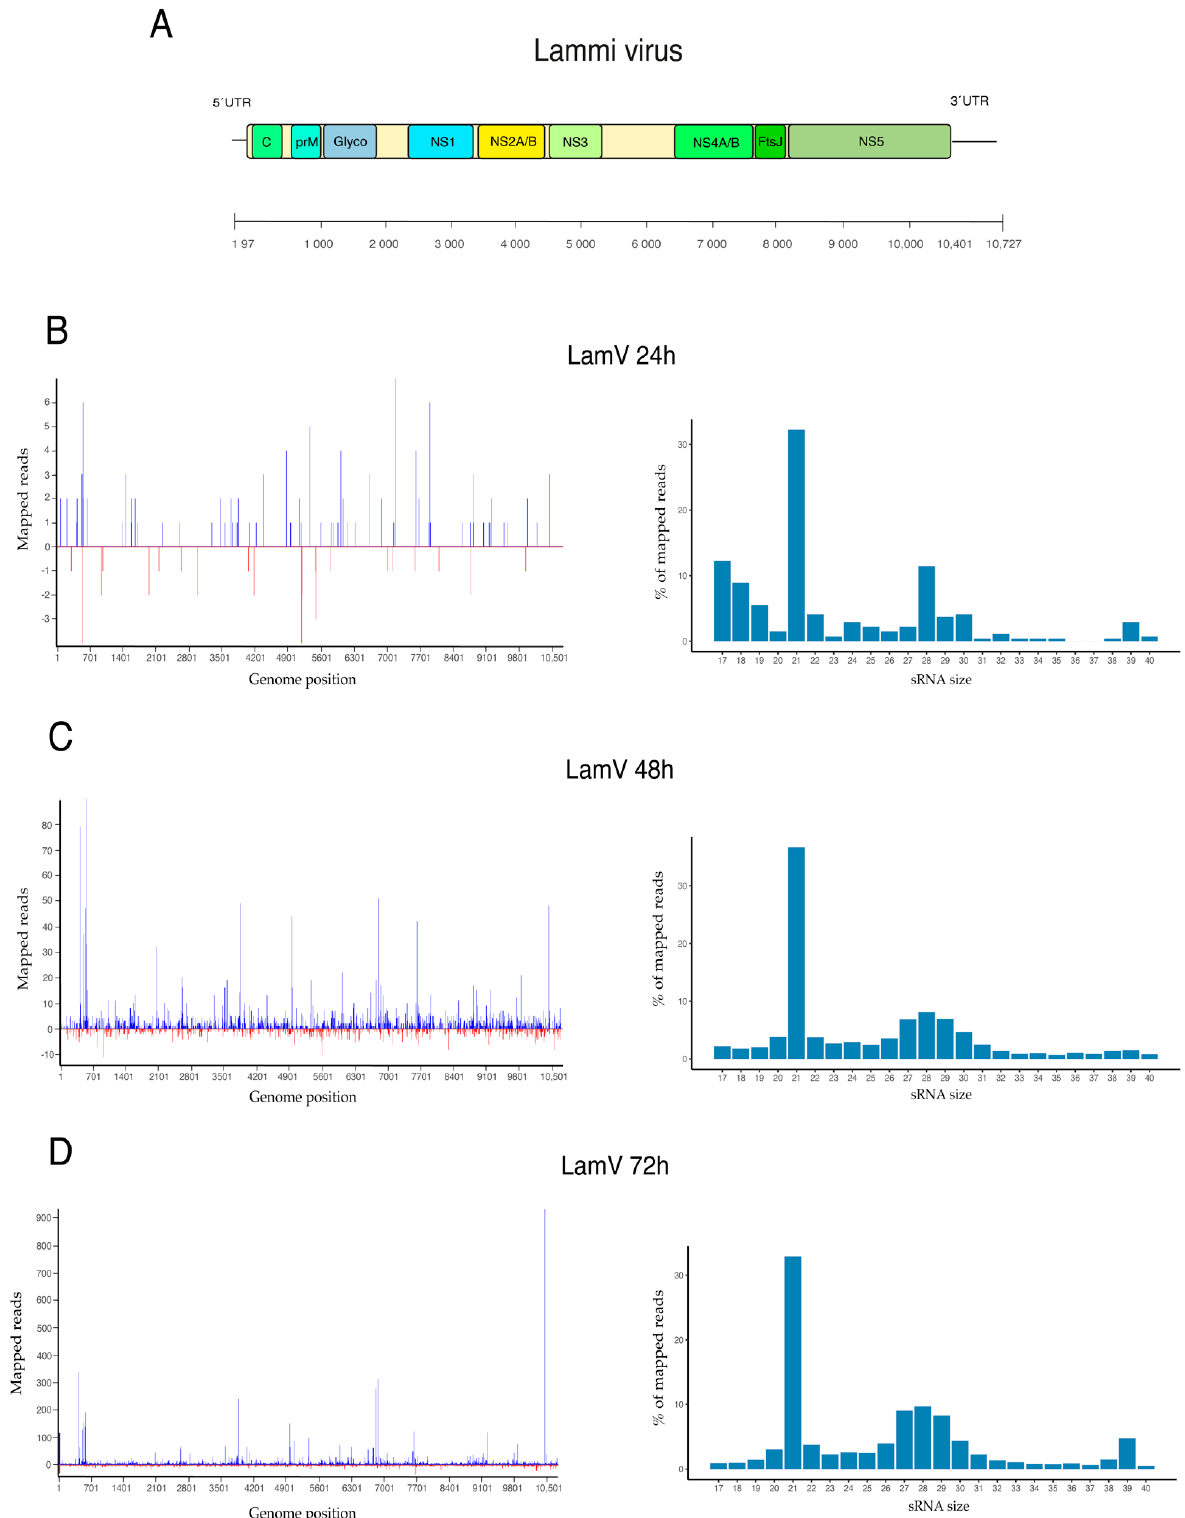
Figure 3. Viral small RNA profiles of U4.4 cells after LamV infection. ( A ) Schematic representation of the LamV genome and vsRNA profiles at 24 h ( B ), 48 h ( C ), and 72 h ( D ) p.i. Figures to the left show vsRNA reads along the LamV genome as a histogram. The positive values (blue) are counts of sRNAs mapped to the sense strand, and the negative values (red) are those mapped to the antisense strand. Figures to the right show the size distribution of reads that mapped to the LamV